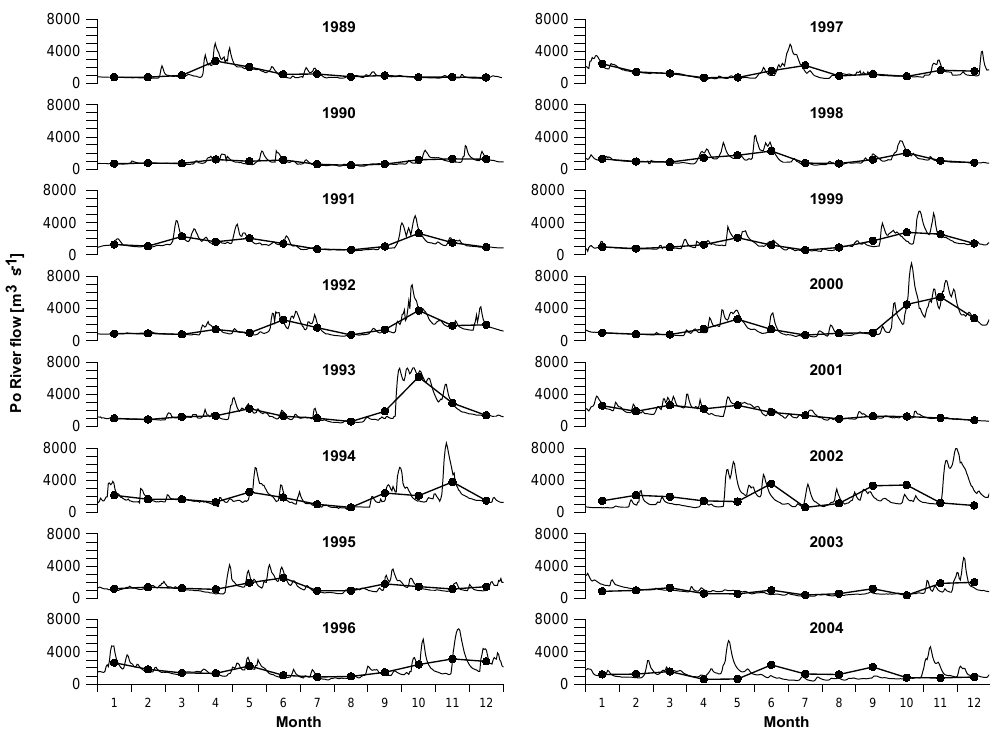
Figure 5. Daily Po River flow (thin line) with monthly averages (thick line with dots) in the analysed years